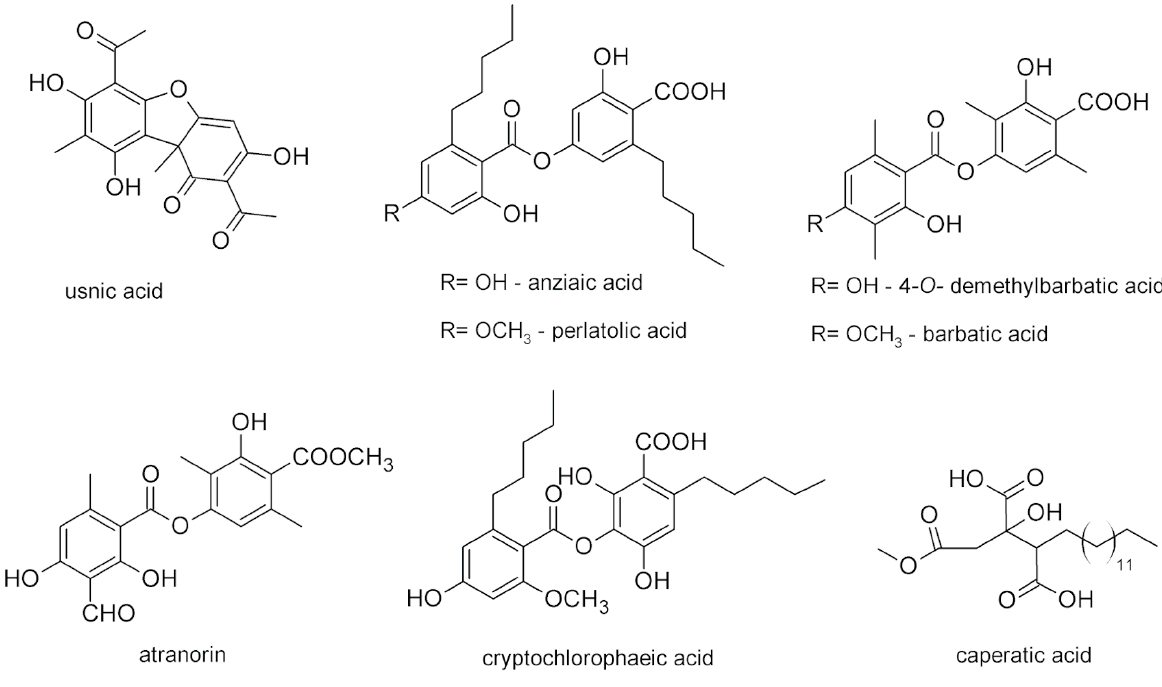
Figure 1. Chemical structures of compounds with antimicrobial activity according to bioautography